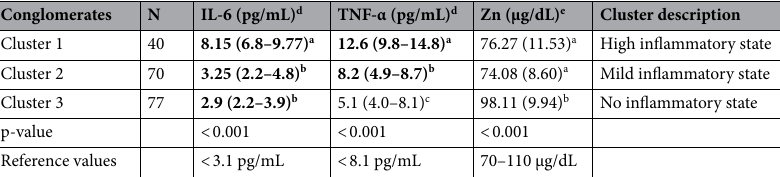
Table 1. Characterization of the inflammatory state distributed into clusters formed by inflammatory cytokines and zinc in the plasma of institutionalized older people. IL-6 interleukin 6, TNFα tumor necrosis factor α, Zn zinc. Bold text indicates values outside the reference levels. a/b/c Different letters indicate a statistically significant difference between the variables. d Data are presented as median and interquartile range considering nonparametric data. e Data are distributed as mean and standard deviation considering parametric